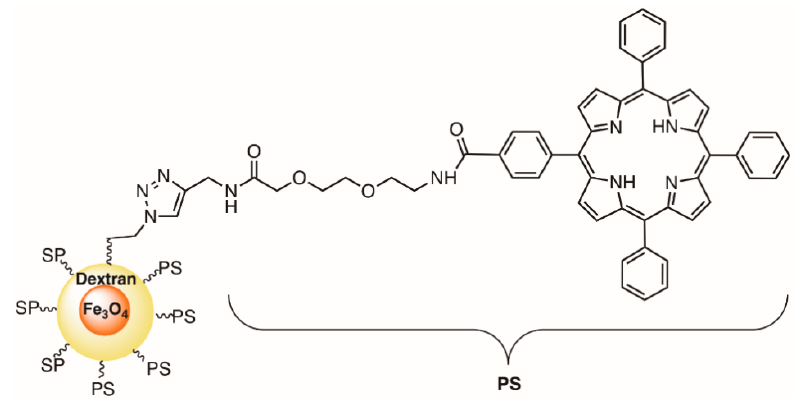
Figure 30. Structure of the SPION-MCTPP (adapted from References [150,151]).